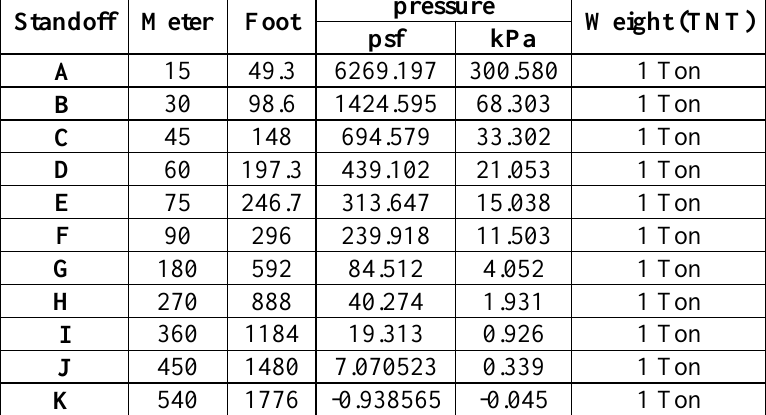
Fig. 8: (a) pressure distribution from 2212.389 Ibs (1 ton) of TNT with a standoff distance of 49.3 ft (15m) and above the ground1.64 ft (0.5m). (b) Blast wave distribution track. Table 1: The blast pressure dimension effect with the parameter bomb explosion quantity, by apply equations 1, (1m=3.289 foot) and kpa=20.857